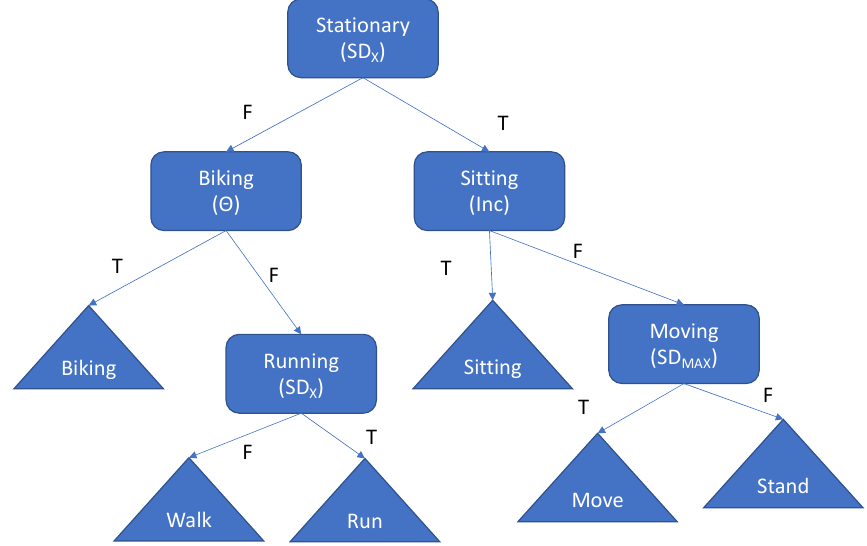
Figure 1. Decision tree implemented for identifying sitting, standing, walking, running, biking and moving (T = true, F = false). SD X is the standard deviation of the acceleration in the x direction, Θ is the backward/forward angle, Inc is the inclination angle and SD MAX is the maximum standard deviation of the acceleration across all axes.